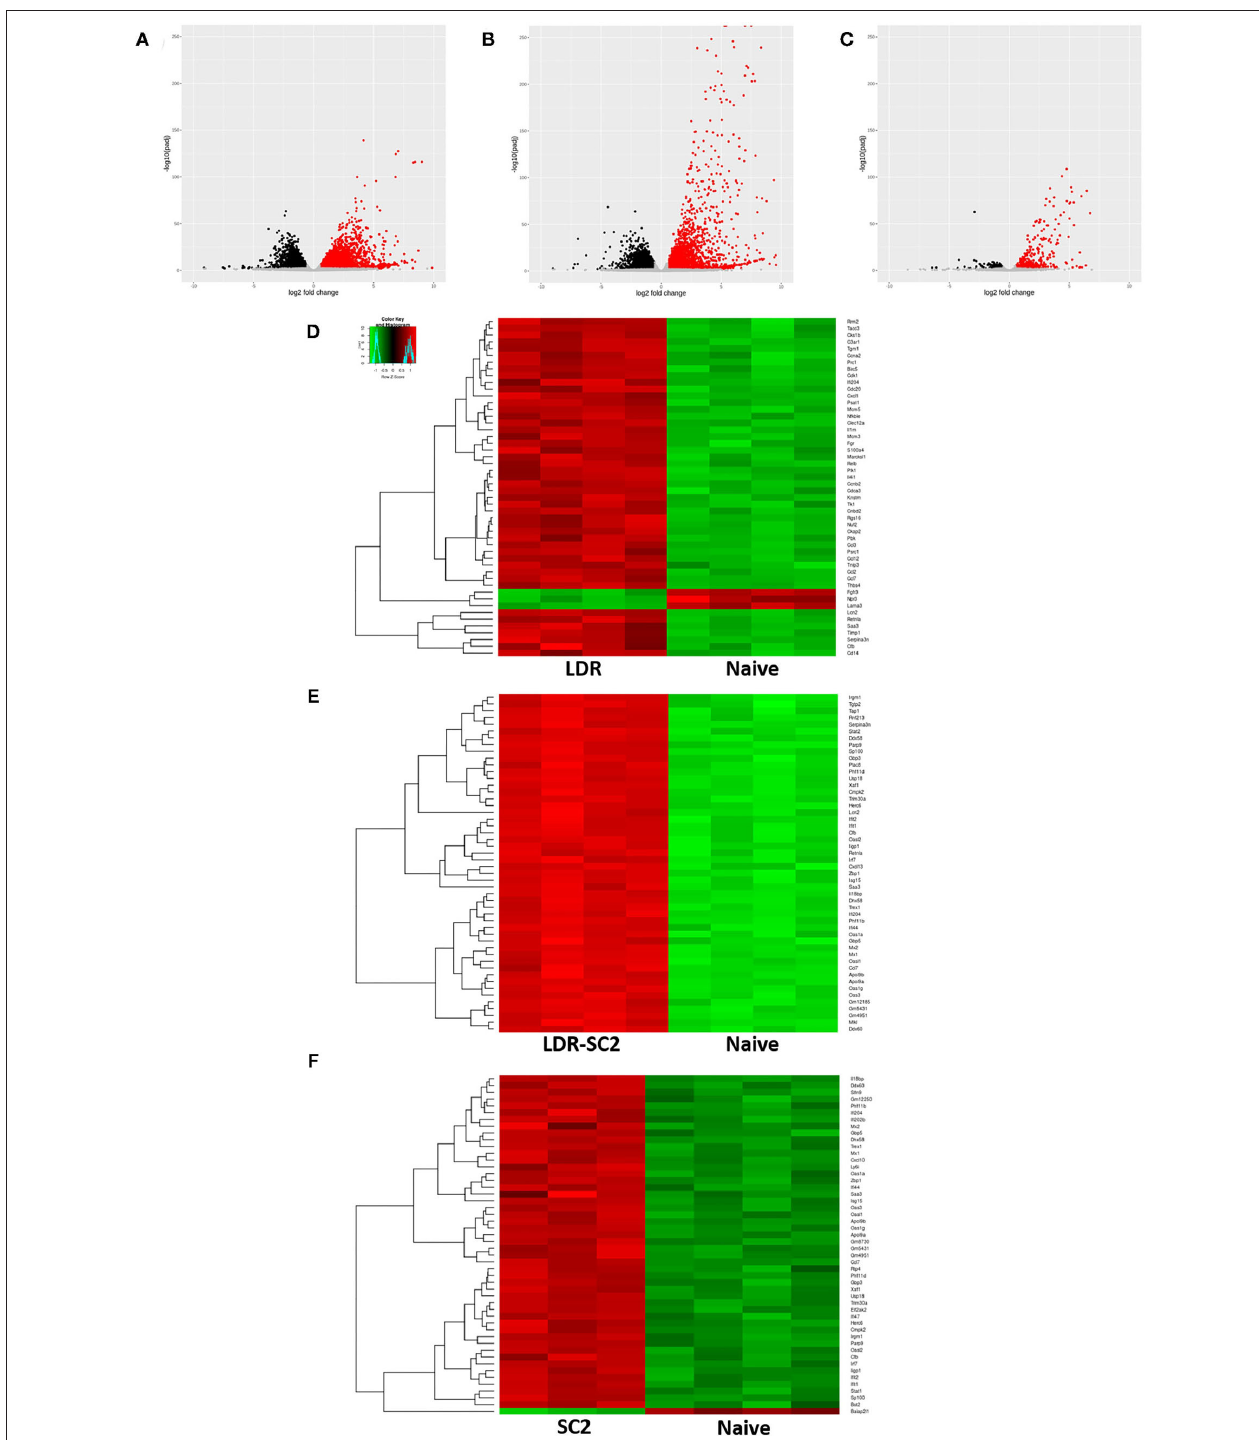
FIGURE 2 | RNA-seq data analysis. (A–C) Volcano plot representation of differential expression analysis of genes in the LDR (A) , LDR-SC2 (B) and SC2 (C) treatment groups vs. naïve mice. Black and red dots mark the genes with significantly decreased and increased expression, respectively ( p ≤ 0.01). The x-axis shows log2 fold-changes in expression and the y-axis the p-value (log10) of a gene being differentially ex-pressed. (D–F) Heatmap of hierarchical clustering performed for the 50 top DEGs (ranked by p-adjusted value) indicating differentially expressed genes (rows) in LDR (D) , LDR-SC2 (E) and SC2 (F) treatment groups vs. naïve mice (fold-change ≥ 1.5 or ≤ 0.66, P < 0.01). Notice the clear presence of groups of genes that are systematically, either up-regulated (red) or down-regulated (green) in each analyzed group, n = 3–4.